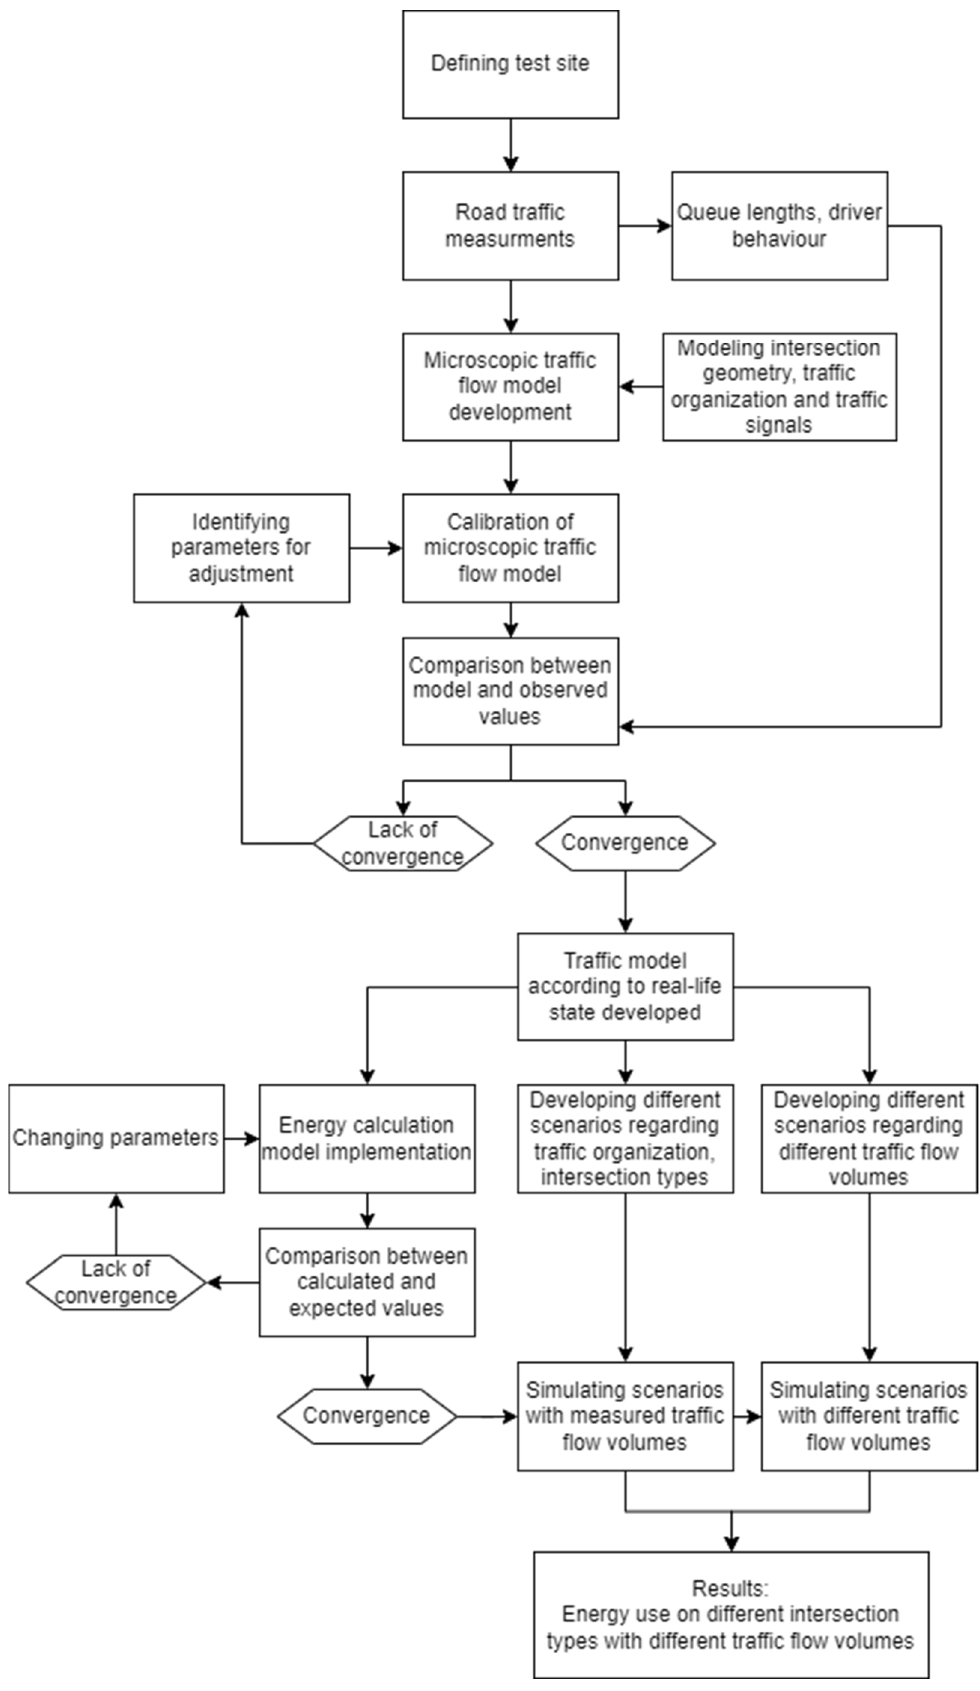
Figure 1. Methodology for conducting research.